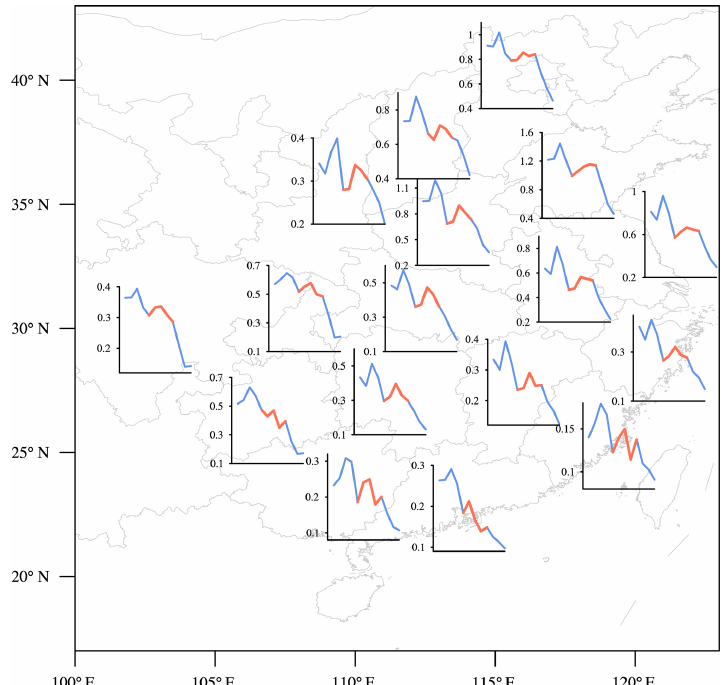
Figure 8. Temporal evolution of annual SO 2 (unit: DU) from 2005 to 2016 in each province of eastern China, with the segment over 2009– 2013 highlighted by red color.